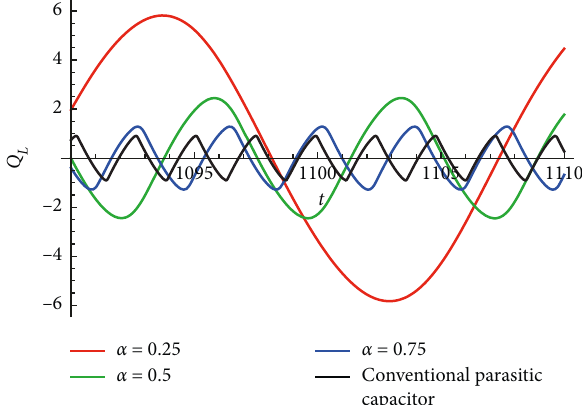
Figure 9: Q L vs φ of the memristor-inductor circuit with the parasitic fractional capacitor/conventional parasitic capacitor [9].